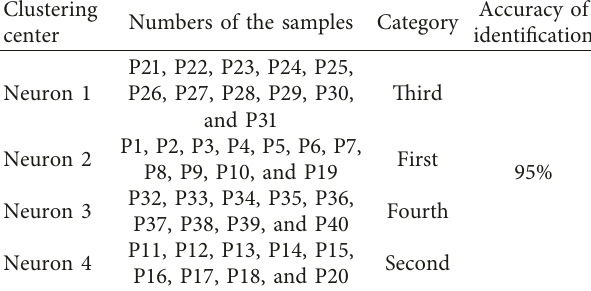
Table 5: Identification